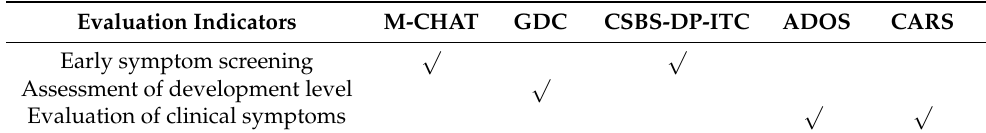
Table 1. Assessment tools for ASD vocalization experiment. Evaluation Indicators M-CHAT GDC CSBS-DP-ITC ADOS CARS √ Early symptom screening